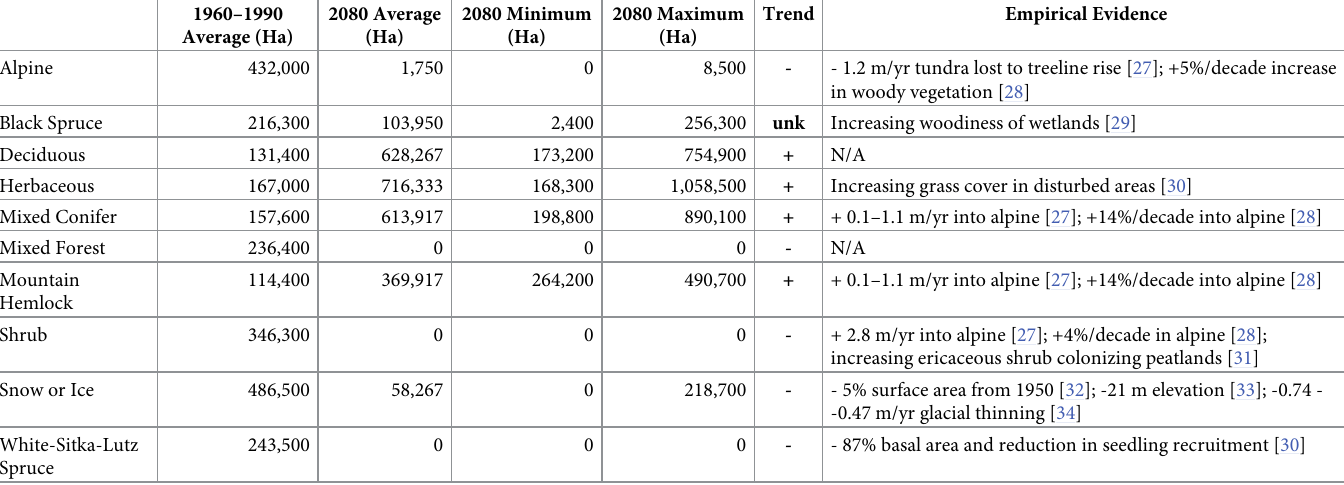
Table 6. Ecological trajectories. Mean, minimum and maximum hectares of each vegetation community forecast by the climate envelope model across 6 model outputs on the Kenai Peninsula, Alaska. Model outputs vary across 2 RCPs and 3GCMs. Trends are assessed by comparing the range with the hectares from the 1km 2 vegetation. 1960–1990 Average (Ha)